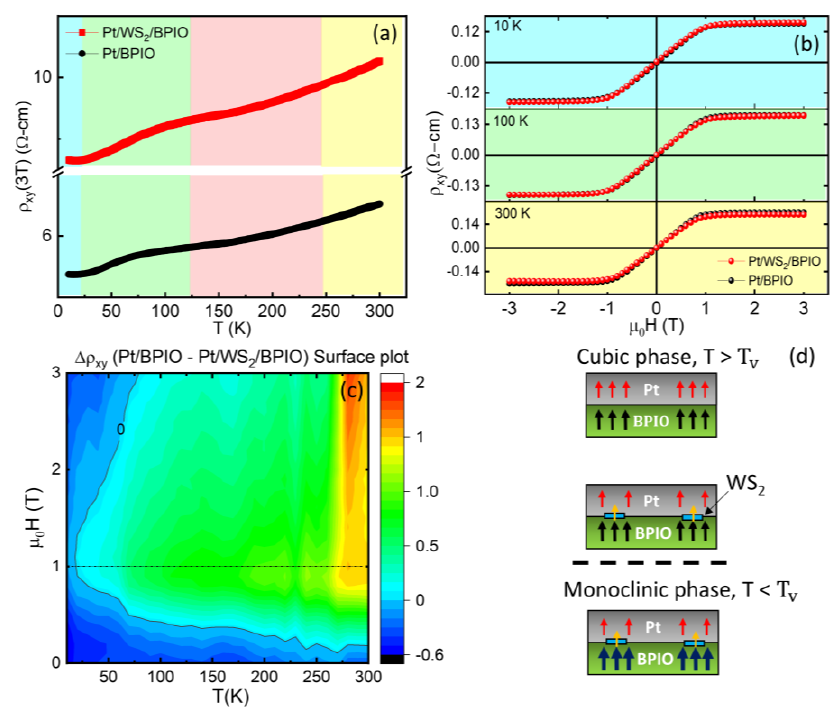
Figure 6. AHE measurements for Pt/BPIO and Pt/WS 2 /BPIO: ( a ) temperature − dependent ρ xy at 3 T and ( b ) ρ xy at selected temperatures of 10, 100, and 300 K. ( c ) 2D surface plot of the ρ xy difference between Pt/BPIO and Pt/WS 2 /BPIO. ( d ) Schematics showing possible differences in MPE between different Fe 3 O 4 phases (cubic and monoclinic) and Pt, as well as the insertion of WS 2 . Red, black, and yellow arrows indicate Pt, WS 2 , and BPIO magnetization, respectively.